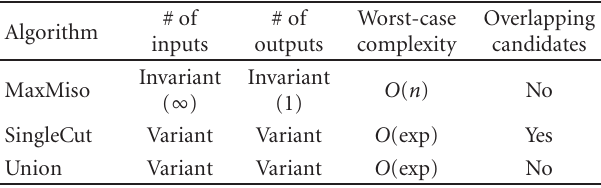
Table 1: Candidate identification ISE algorithms comparison.